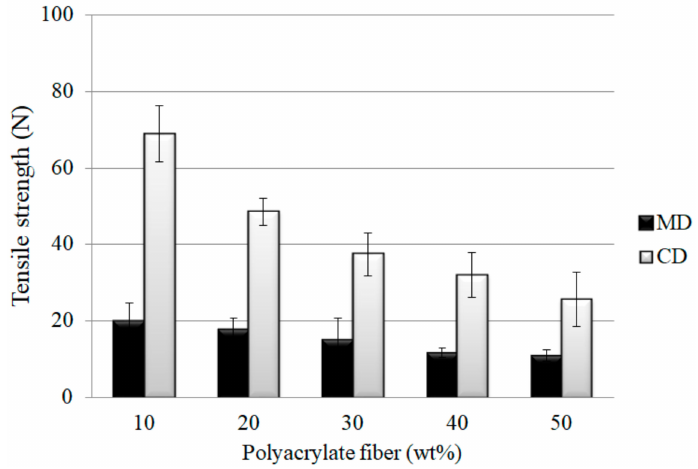
Figure 2. Tensile strength of PT nonwoven composites as related to the content of polyacrylate fibers and fiber orientation.